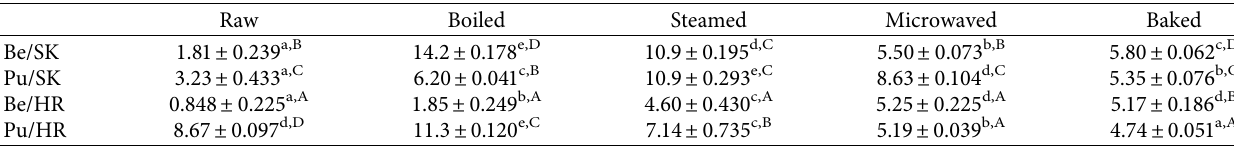
Table 3: Total antioxidant capacity ( μ mol TE/g DW).